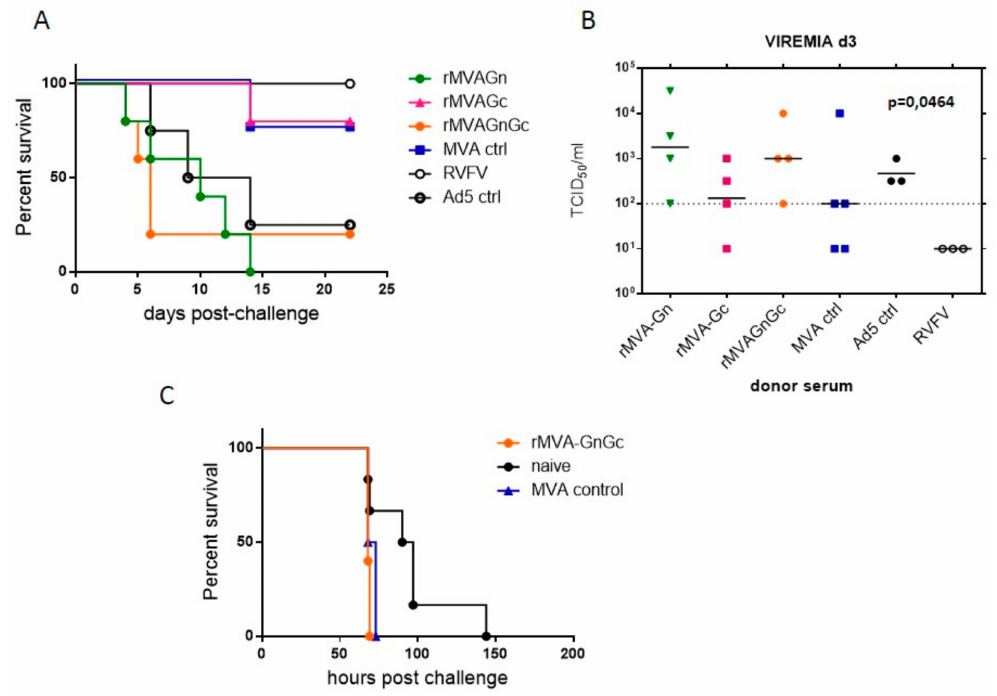
Figure 6. E ff ect of rMVA immune serum in BALB / c survival. Mice ( n = 5) were passively transferred with a mixture of immune serum from MVA vaccinated mice and 5 × 10 3 pfu of virulent 56 / 74 RVFV. For positive and negative control groups n = 4 was used. ( A ). Kaplan–Meier plots of survival proportions. The mice were monitored for 3 weeks for the presence of signs of disease. ( B ). Viremia at day three post inoculation tested by tissue culture infection doses in Vero cells. The infectious titer of each sample is defined as the reciprocal of the highest dilution of serum where a 50% of the cytophatic e ff ect (cpe) is observed relative to noninfected controls. Only samples allowing a clear cpe determination are included. Samples inducing a non cpe-like e ff ect were excluded. When no evident cpe was observed an arbitrary value of 10 1 TCID 50 below the sensitivity limit (10 2 ) was assigned. Black lines represent means. Dotted line represents the sensitivity of the assay. The ANOVA test p value for di ff erences among means is indicated. ( C ). Kaplan–Meier plots of BALB / c survival upon transfer with the rMVA ovine immune